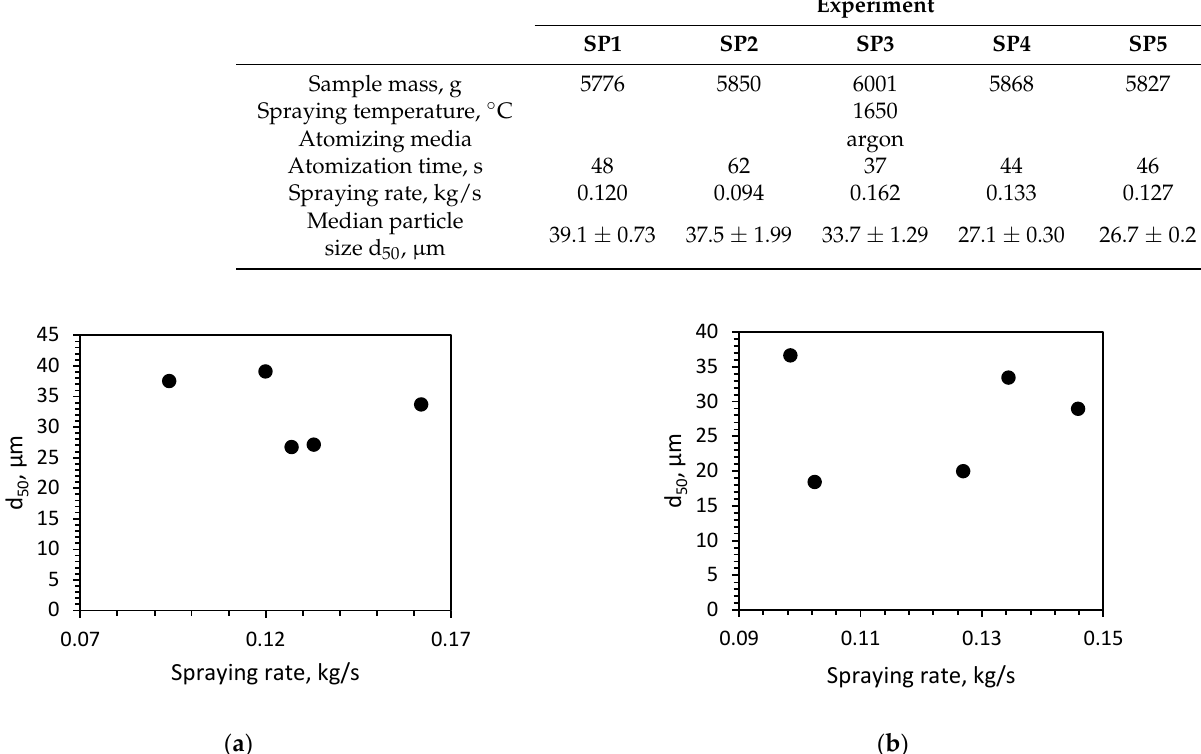
Figure 3. Effect of spraying rate on the median particle size of atomized powder d 50 : in this work ( a ); and in the selenium alloyed series (ST-modified) reported in [17] – ( b ).